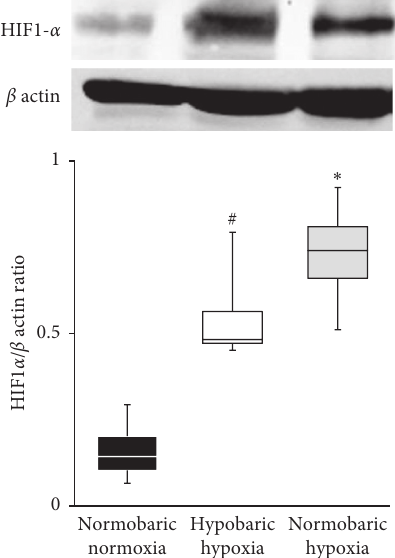
Figure 5: HIF1 α / β actin ratio in the three groups in rat myo- cardium sampled from the left ventricle just after exposure to each condition. Representative immunoblots from all groups are pre- sented. Arrows indicate positions of HIF1 α and β actin bands. Data are shown as median and interquartile range (IQR), n � 4 rats per group. # p < 0.05; ∗ p < 0.01 vs. normobaric normoxia group by one- way analysis of variance (ANOVA) followed by Tukey’s post hoc